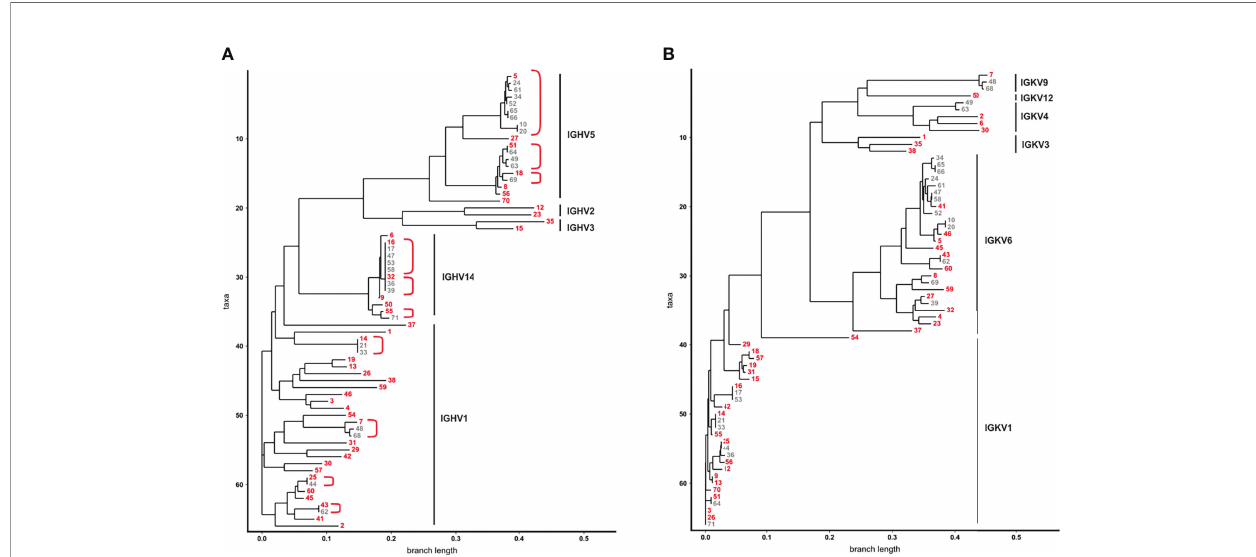
FIGURE 2 | Dendrograms showing the similarity of VH and VL aa sequences from 66 phage antibodies after the second panning round. (A) VH and (B) VL of 66 scFv phage antibodies after the second panning round were Sanger sequenced and aligned by ClustalW using Neighbour Joining to represent similarities of aa sequences as dendrograms. The 66 VH aa sequences are represented by 41 VH clonotypes. For each of the 41 VH clones one member was chosen as a prototype (red) for further analysis. VH aa sequences sharing the same VH clonotype are grouped together in red brackets. The V gene subgroups are according to IMGT and are indicated on the